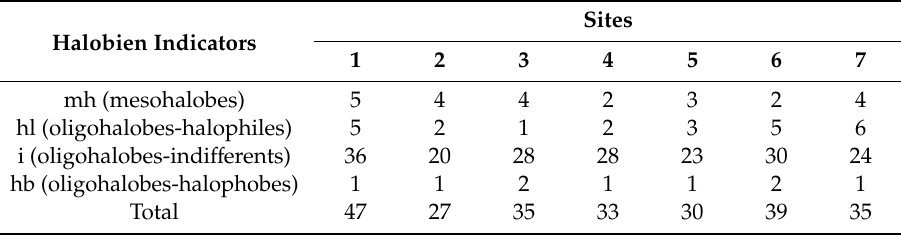
Figure 4. Delineation of salinity (halobien system, H) indicators in Sasyk Reservoir during the August 2018. Table 2. Species indicators of salinity (according Hustedt, 1938–1939, Barinova et al., 2019) extracted from the sampling stations at the Sasyk Reservoir during August